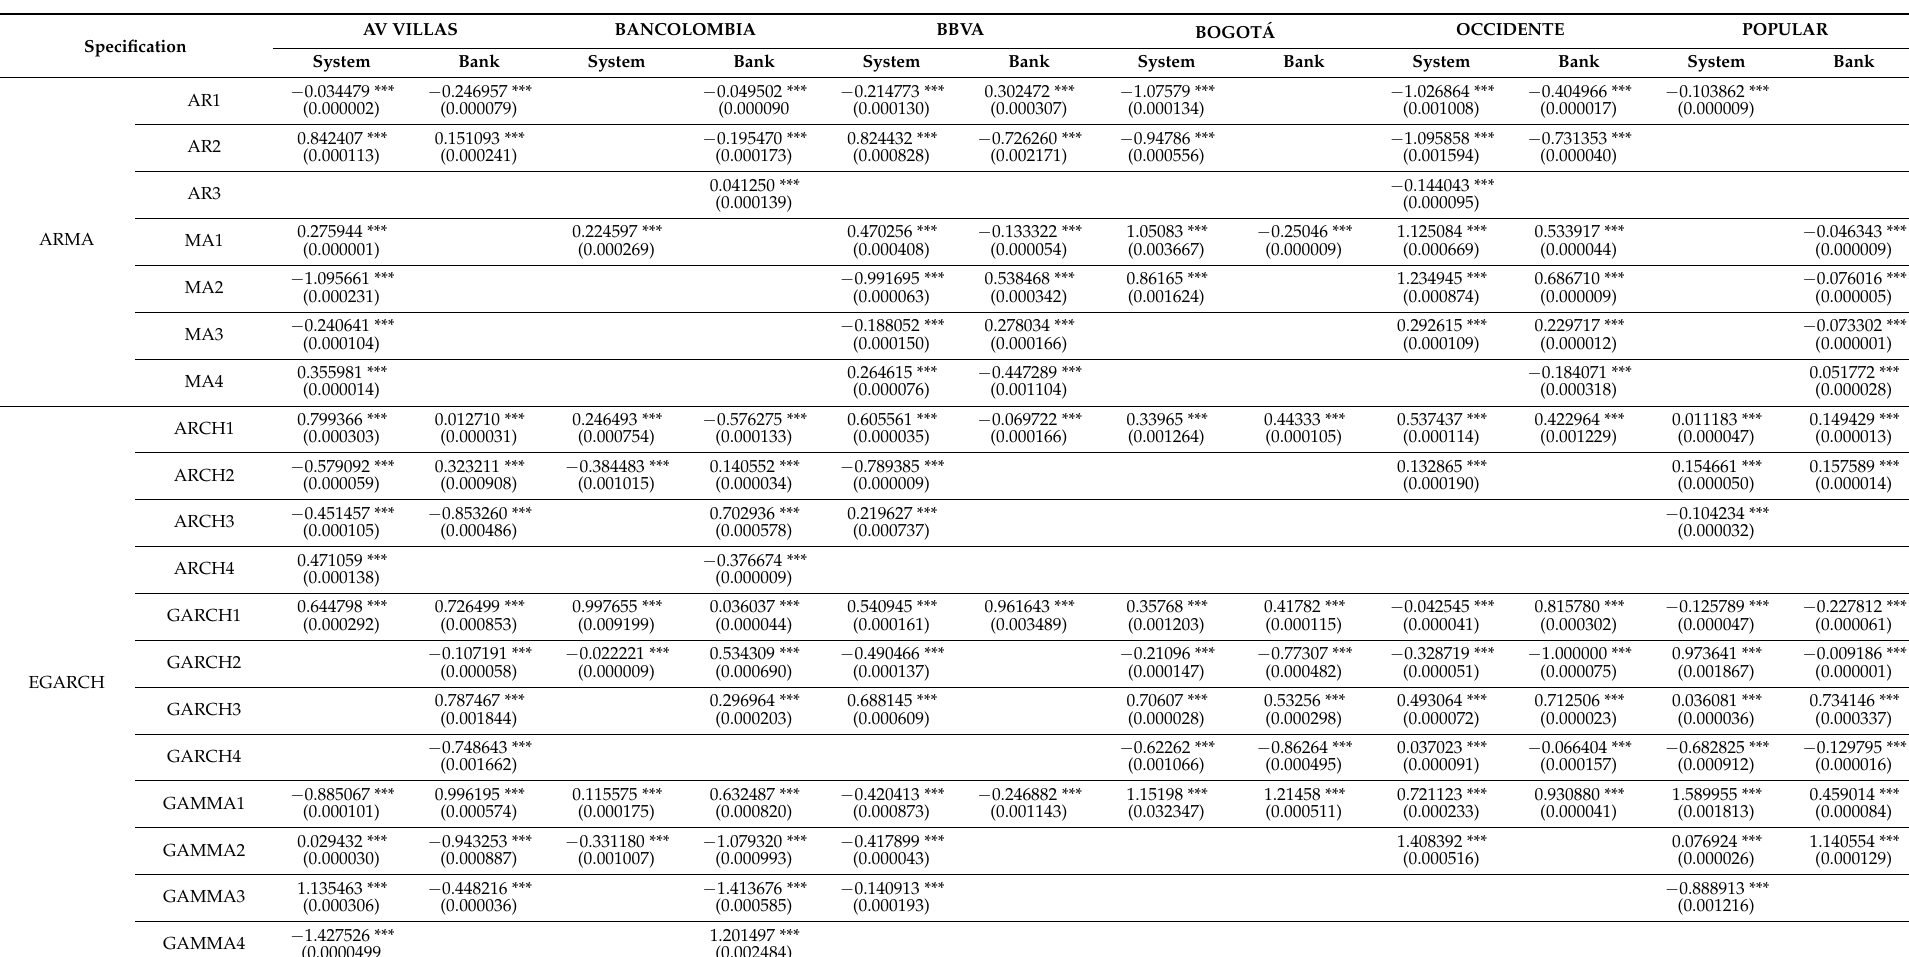
Table 2. ARMA and EGARCH results for the sample